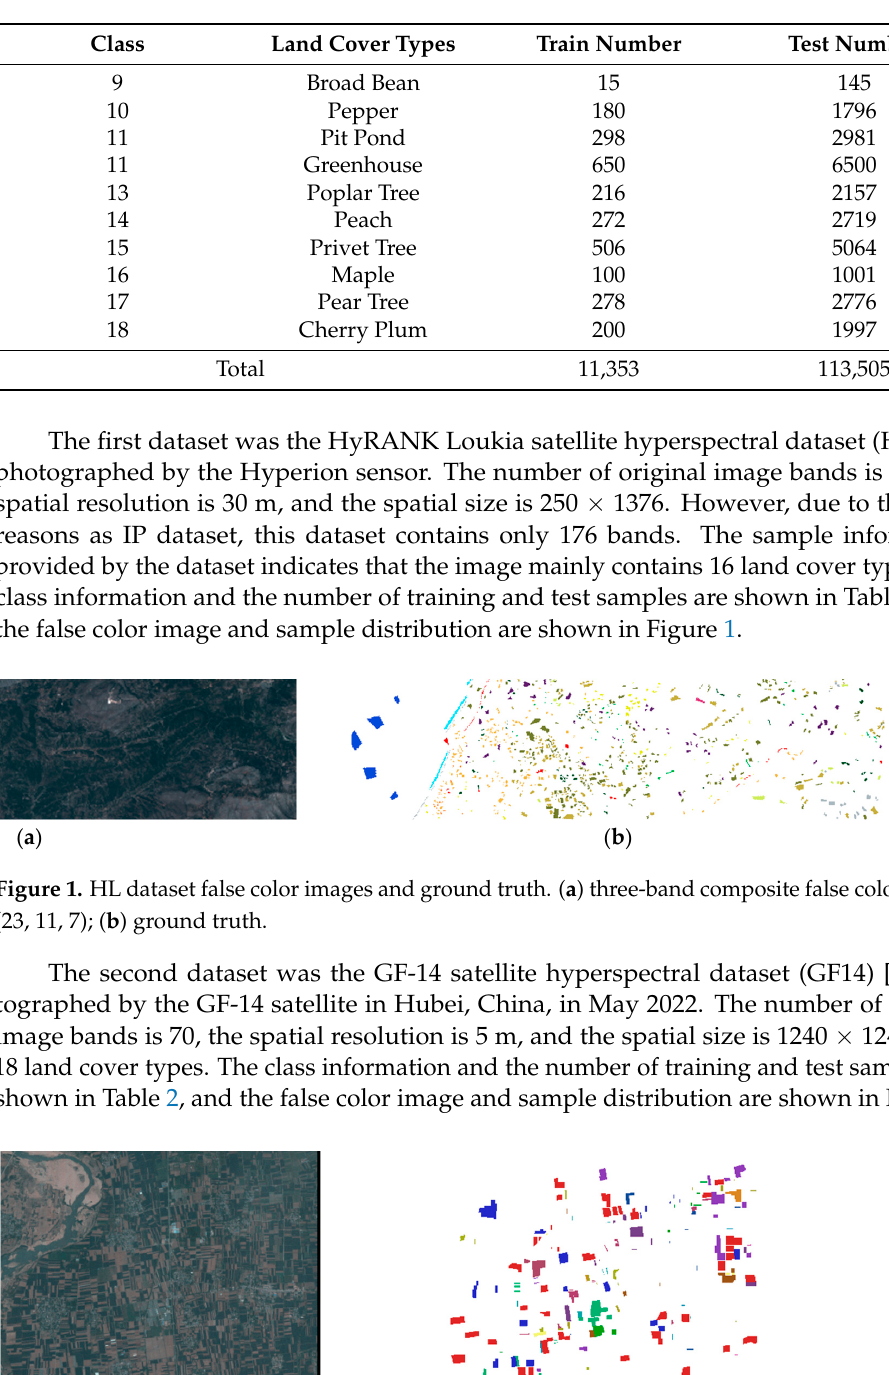
Figure 2. GF14 dataset false color images and ground truth: ( a ) three-band composite false color images (25, 11, 7); ( b ) ground truth. Table 1. Land cover classes with samples number for the HL dataset.